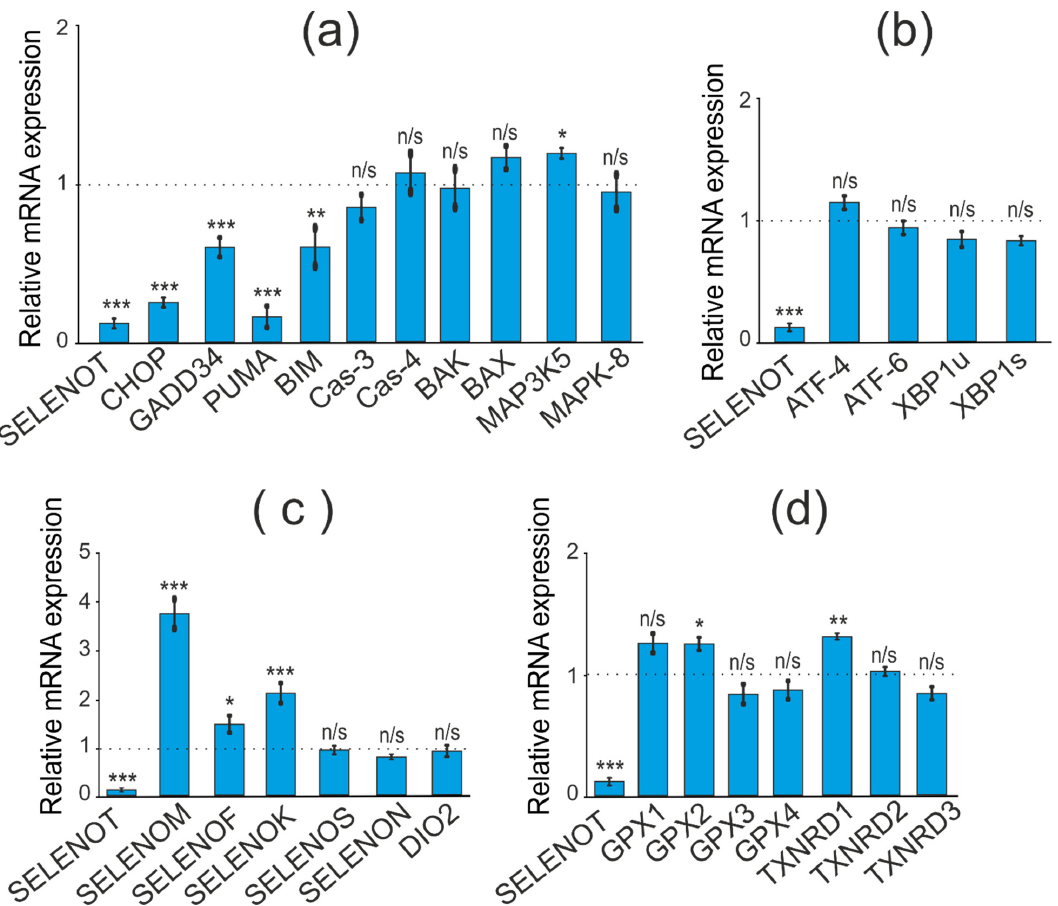
Figure 6. Comparative analysis of mRNA expression patterns of various genes under SELENOT- KD and without SELENOT-KD conditions, obtained using real-time PCR. ( a ) mRNA expression of pro-apoptotic genes; ( b ) mRNA expression of markers of three UPR signaling pathways; ( c ) mRNA expression of ER resident selenoproteins; ( d ) mRNA expression of selenium-containing glutathione peroxidases and thioredoxin reductases. Comparison of experimental groups regarding control, indicated as dash line (1): n/s—data not significant ( p > 0.05), * p < 0.05, ** p < 0.01, and *** p < 0.001.